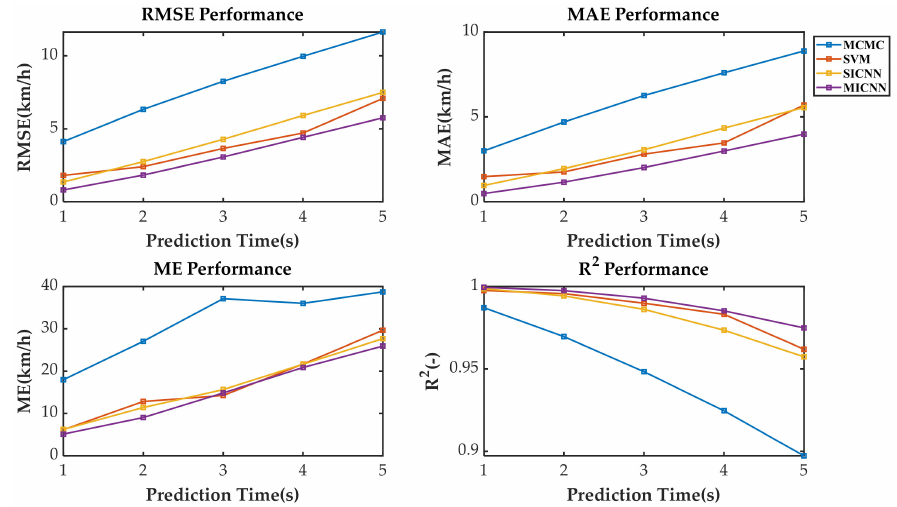
Figure 13. The performances of the four